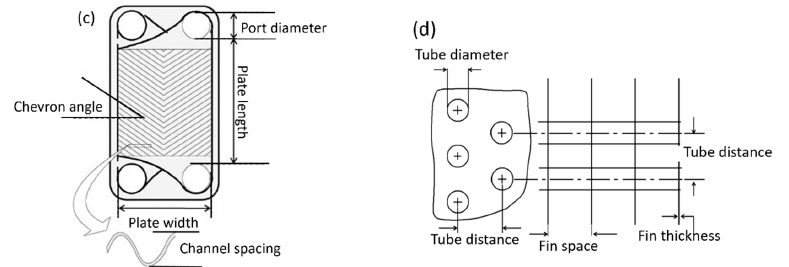
Figure 3. ( a ) Schematic diagram of the constant pressure pump secondary loop model; ( b ) schematic diagram of the vapor compression secondary loop model; key geometric parameters of the ( c ) chevron plate evaporator and ( d ) plate fin condenser are also shown. Table 1. Secondary loop evaporator and condenser key geometric parameters.